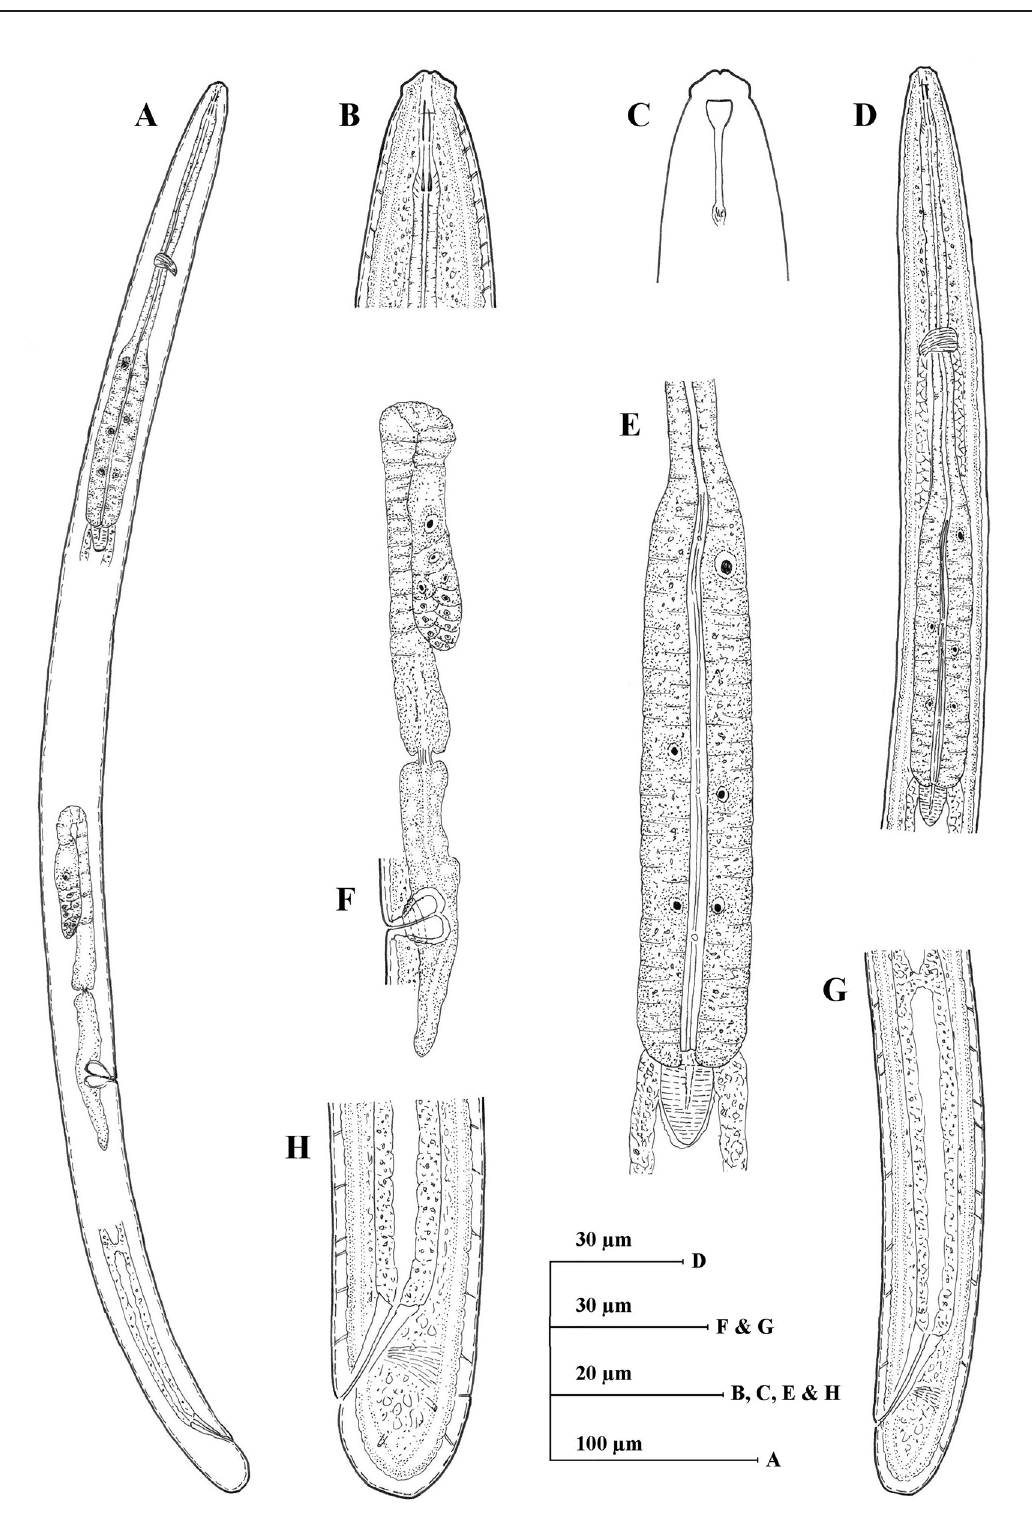
Fig. 15. Tylencholaimus tamiliensis sp. nov., ♀. A, C–F . Paratype 5 (slide 3). B . Paratype 2 (slide 2). G–H . Holotype (AMU/ZD/NC/ Tylencholaimus tamiliensis /1). A . Entire specimen. B . Anterior region. C . Anterior region showing amphid. D . Pharyngeal region. E . Pharyngeal expansion. F . Genital system. G–H . Posterior